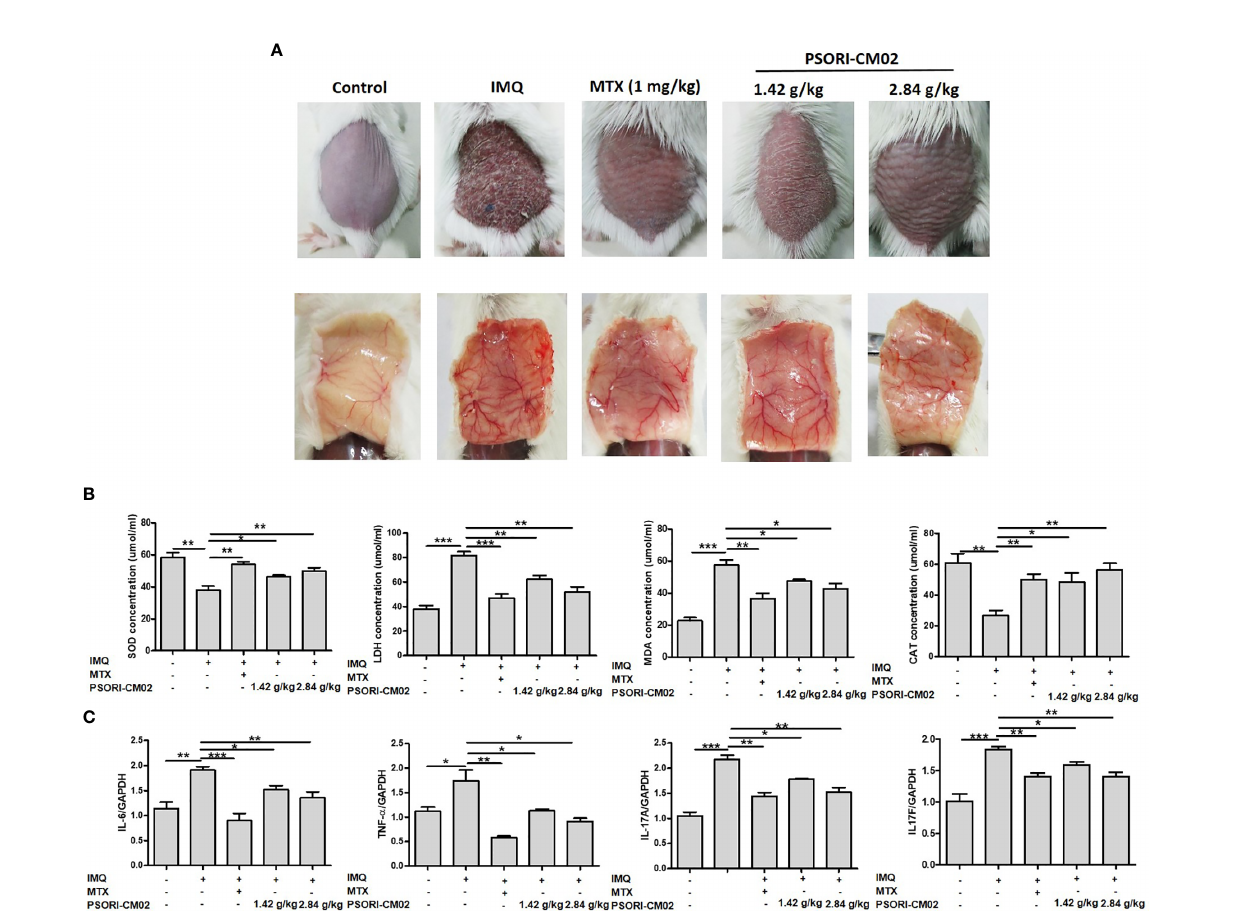
FIGURE 4 | PSORI-CM02 inhibited angiogenesis in mice with imiquimod (IMQ)-induced psoriasis. (A) Photographs of the backs of mice 7 days after the fi rst IMQ application. Mice were randomly divided into fi ve groups, and methotrexate (MTX) or PSORI-CM02 administration began 4 h before daily IMQ cream application for 7 days. (B) Superoxide dismutase (SOD), lactate dehydrogenase (LDH), malondialdehyde (MDA), and catalase (CAT) levels were measured in back skin tissues of mice from each group using commercial assay kits. (C) The mRNA levels of interleukin (IL)-6 ( IL-6 ), tissue necrosis factor- a ( TNF- a ), IL-17A , and IL-17F in mouse skin tissues were determined by RT-PCR. Data represent the mean ± SEM of at least three independent experiments (* p < 0.05, ** p < 0.01, *** p < 0.001 vs. the IMQ- induced psoriasis group; n =